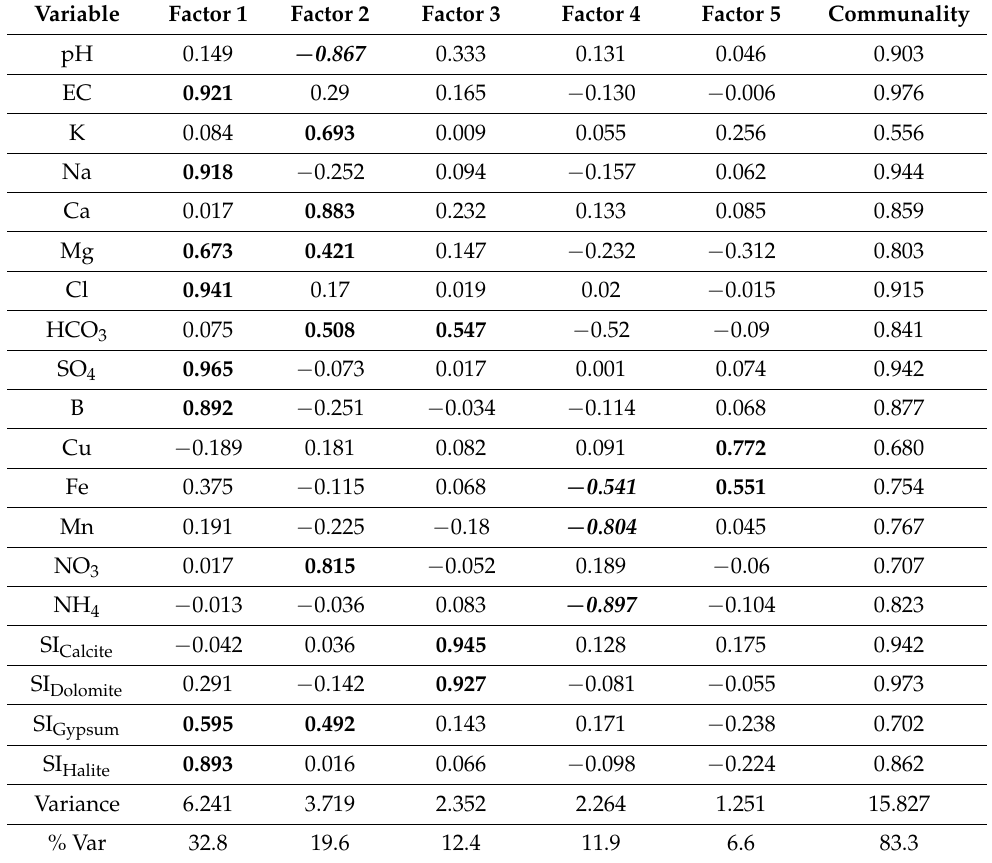
Table 1. Results of Factor Analysis (FA) with rotated (varimax) factor loadings and communalities. Medium-to-high positive correlation is shown in bold, while medium-to-high negative correlation is shown in bold